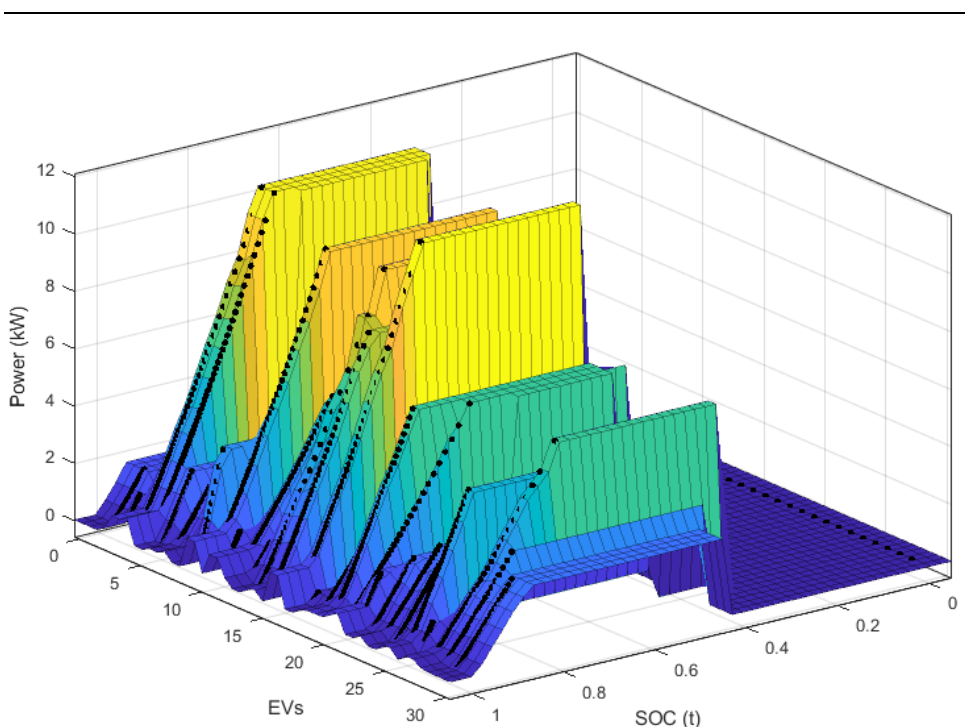
Figure 6. SOC-based charging power of 30 different EVs according to